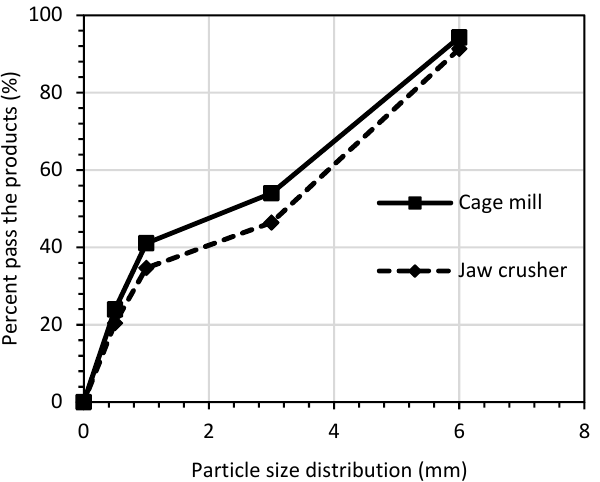
Fig. 4. Comparison of industrial cage mill and the laboratory jaw crusher for the degree of liberation of the middle coal after crushing.